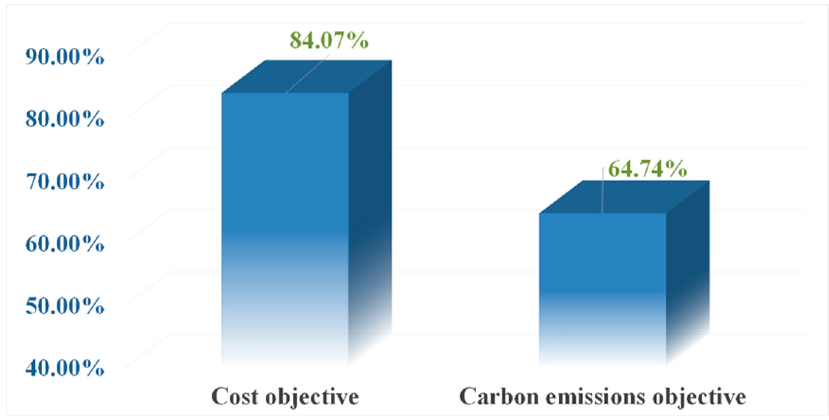
Table 5. Optimal decision variable values.